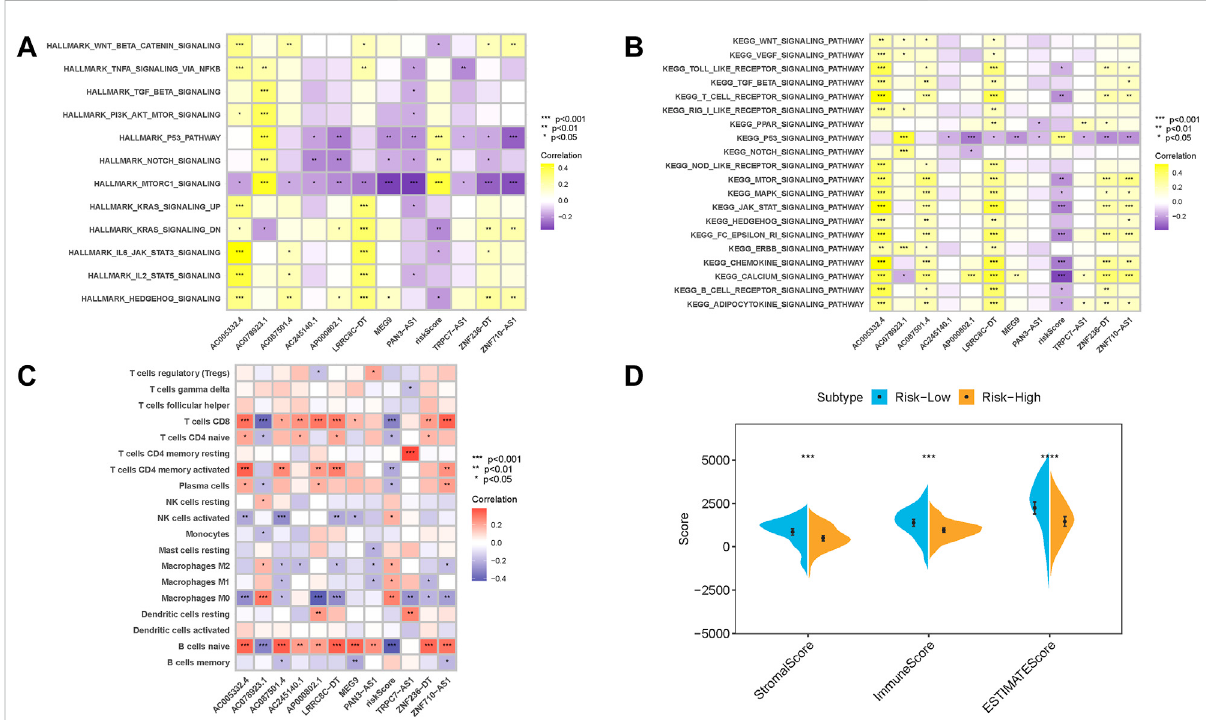
FIGURE 9 Enrichment pathways of GSVA. (A) Heatmap showing the correlation of representative pathway terms of Hallmark with the risk score. (B) HeatmapshowingthecorrelationofrepresentativepathwaytermsofKEGGwiththeriskscore. (C) Correlationanalysisoftheriskscorewithimmune in fi ltration. * p < 0.05; ** p < 0.01; *** p < 0.001. (C) CIBERSORT algorithm; (D) ESTIMATE